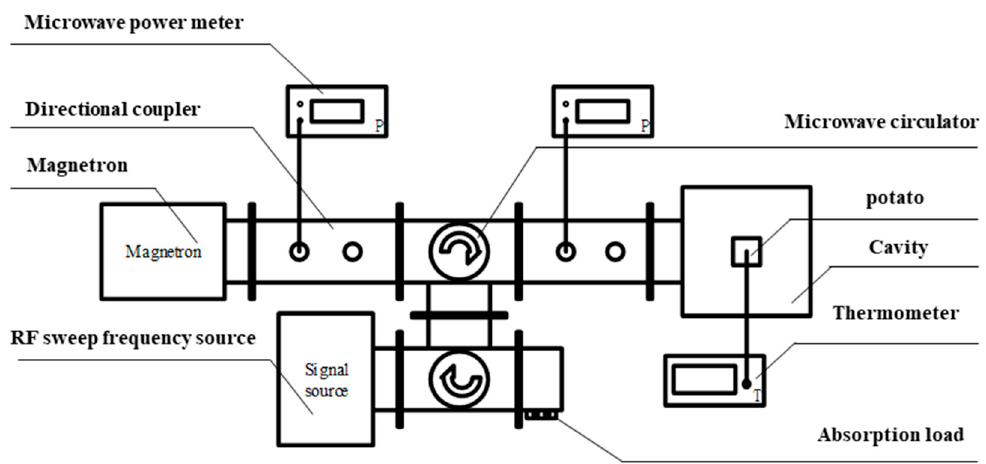
Figure 3. Magnetron injection frequency lock heating system block diagram.